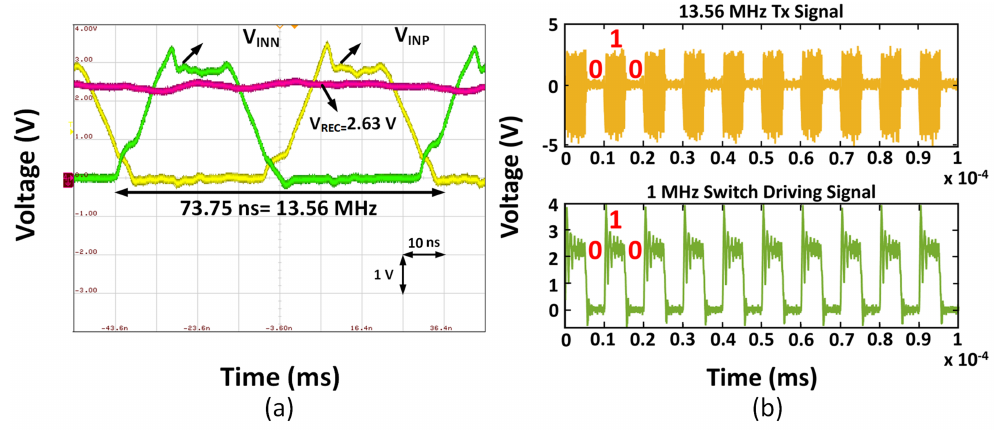
Figure 12. ( a ) Input and output waveform of the rectifier at 13.56 MHz, V IN , peak = 4.2 V, R L = 500 Ω , and C L = 10 µ F, ( b ) transmitter waveform modulation when power switch between receiver antenna inputs is driven with 10 kHz square